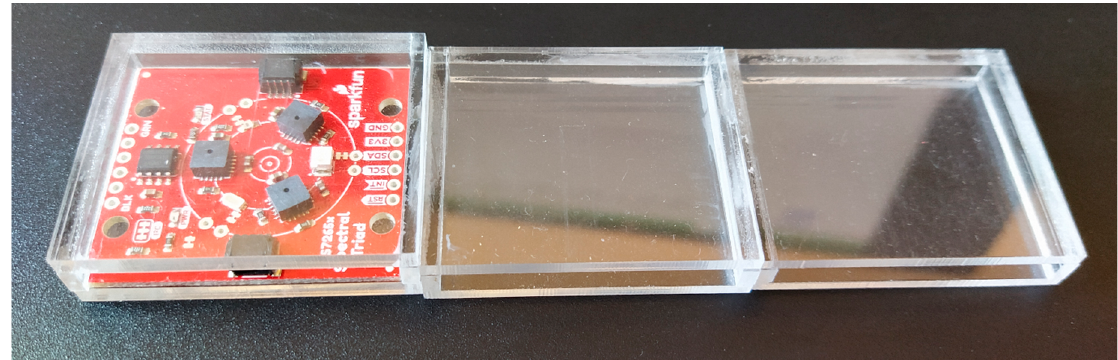
Table 3. Comparison of the means of raw spectral intensity for each color group of the AS7265x.